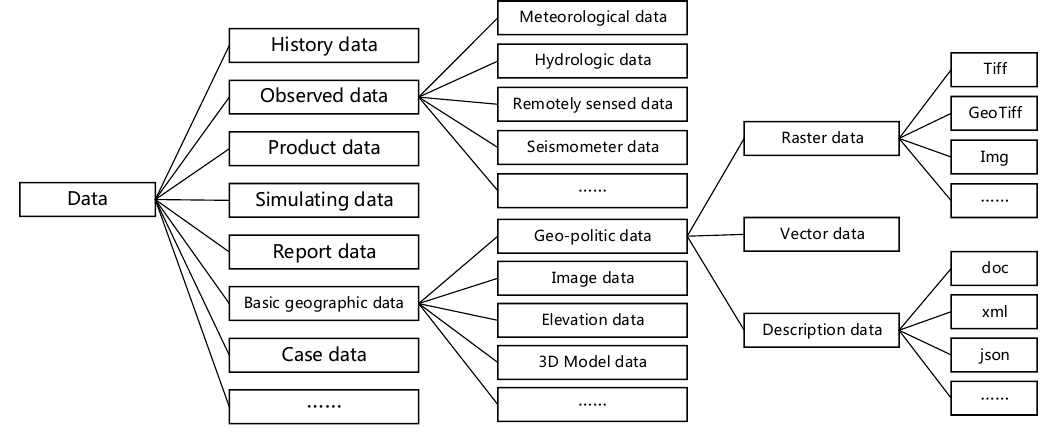
Figure 2. Disaster data